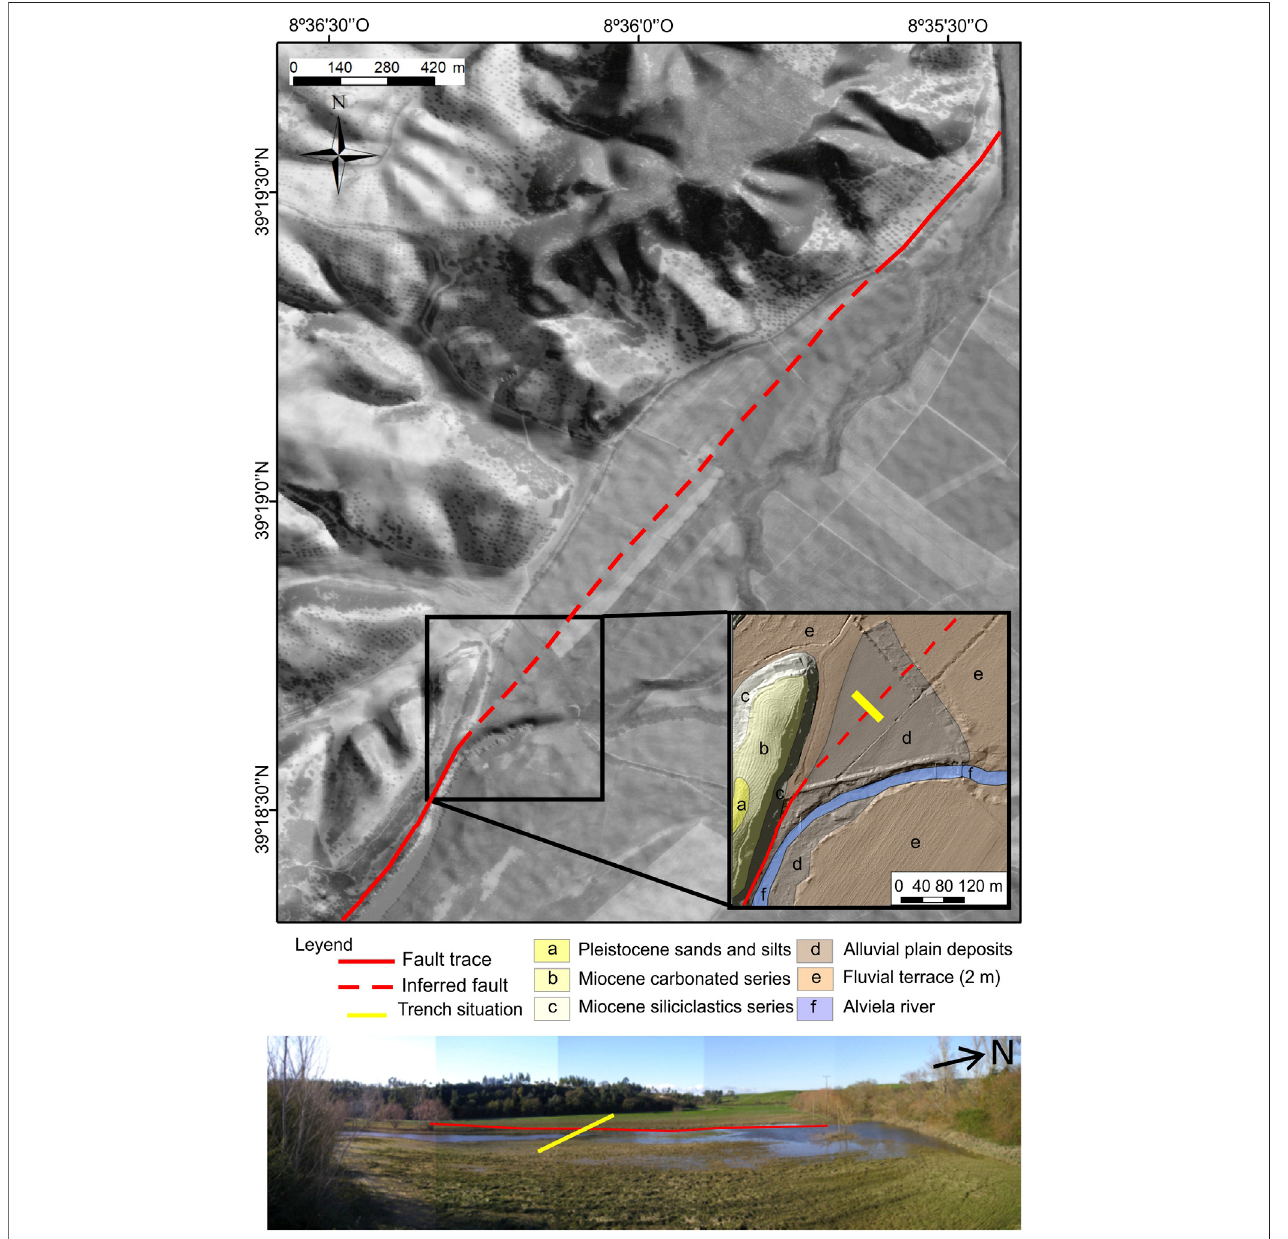
FIGURE5| LocationoftheAlvielatrench-site: (A) aerialphotographsuperimposed onthe0.5 m-resolutionDEM; (B) detailincludingthe1:50.000geologicalmap; (C) Photograph of the very subtle fault scarp, facing NW.